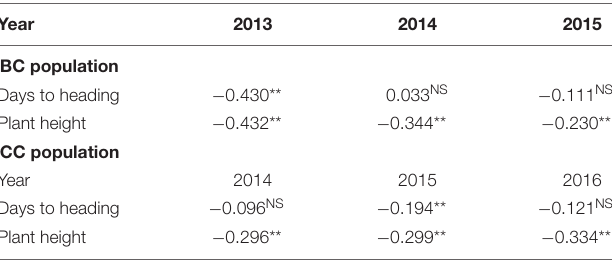
TABLE 2 | Pearson correlation coefficient analysis of spot blotch resistance with days to heading and plant height in BARTAI × CIANOT79 (BC) and CASCABEL × CIANOT79 (CC)